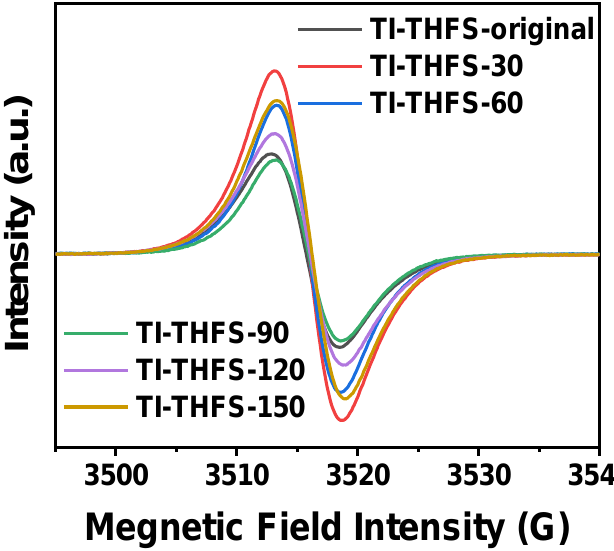
Figure 12. EPR spectra of the TI − THFS fraction.